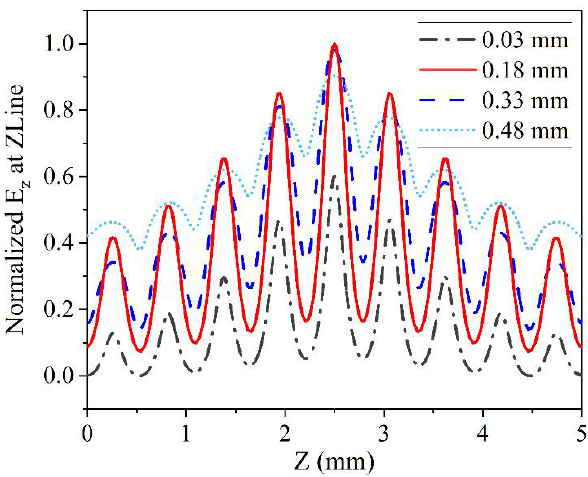
Figure 9. Field E Z along the beam tunnel with different gap lengths.